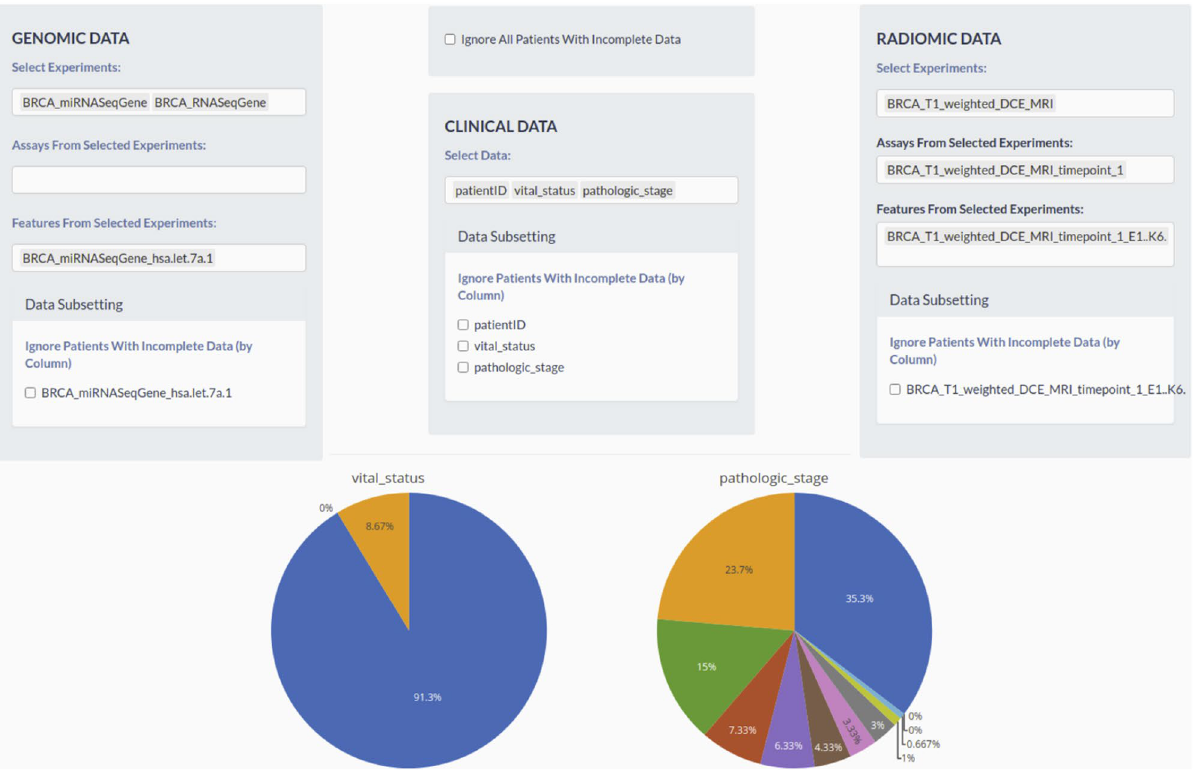
Figure 4. Filtering module. This module allows filtering the data by experiments, assays, features (clinical, radiomic and/or genomic) and complete data (overall – by “Ignore All Patient with Incomplete Data” or for a specific feature). Each type of data can be filtered separately through the specific sub-module. Each menu is dynamically built after a selection. For example, when the user selects an experiment, only features of the experiment are shown in the “feature menu”. A simple graphic statistic plot of clinical data is also shown in this module. The metadata plots show pre-filtering data per stage II. The figure is generated by using R software version 3.6.1 (https ://www.r-proje